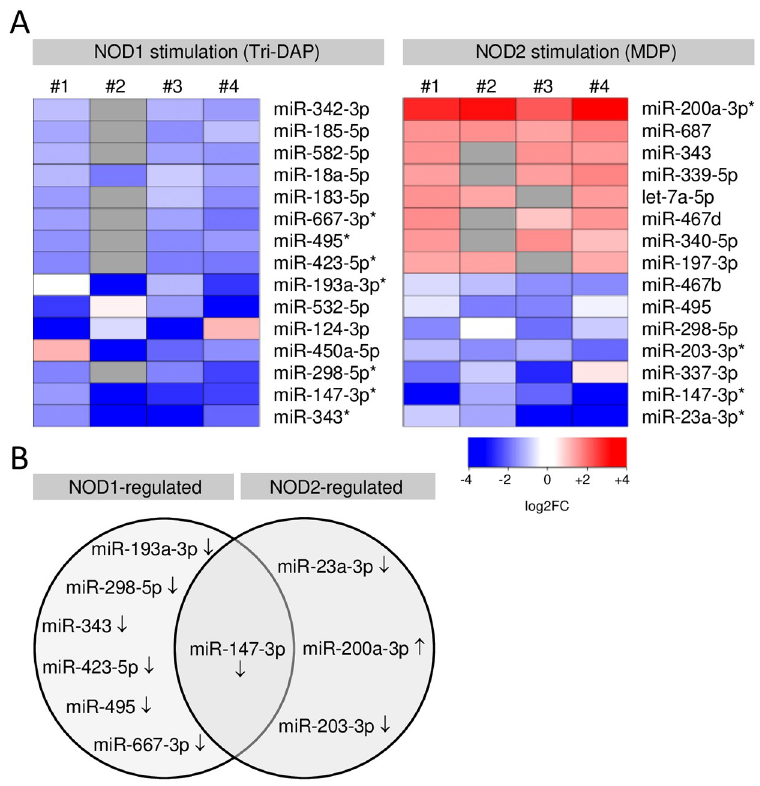
Fig 2. NOD1- and NOD2-dependently regulated miRNAs in murine pulmonary endothelial cells. ( A ) Heatmap showing differentially regulated miRNAs 6 hours following Tri-DAP or MDP stimulation (each 10 μ g/mL) from four independent experiments as determined by TaqMan low-density array (TLDA). � P < 0.05, grey boxes = below threshold. ( B ) Venn diagram showing significantly differentially regulated miRNAs from the heatmap. # down- " up- regulated vs. unstimulated